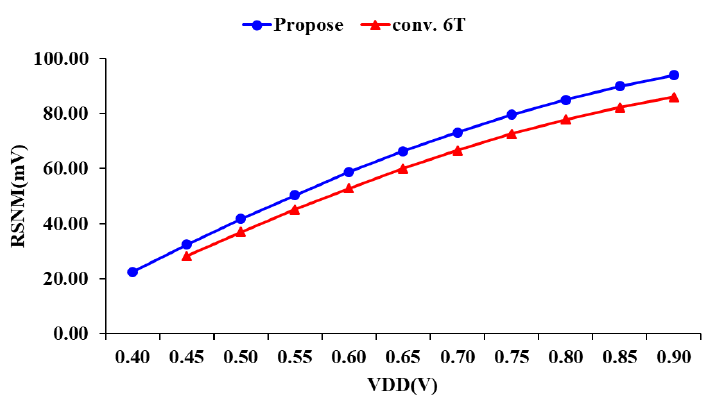
Figure 5. The RSNM comparison for optimal and (conv.) pre-charge.